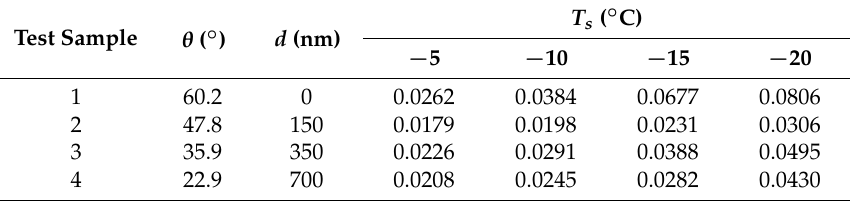
Table 7. The frost mass of the different samples under different surface temperatures, and at T a = 5 ◦ C and ϕ =